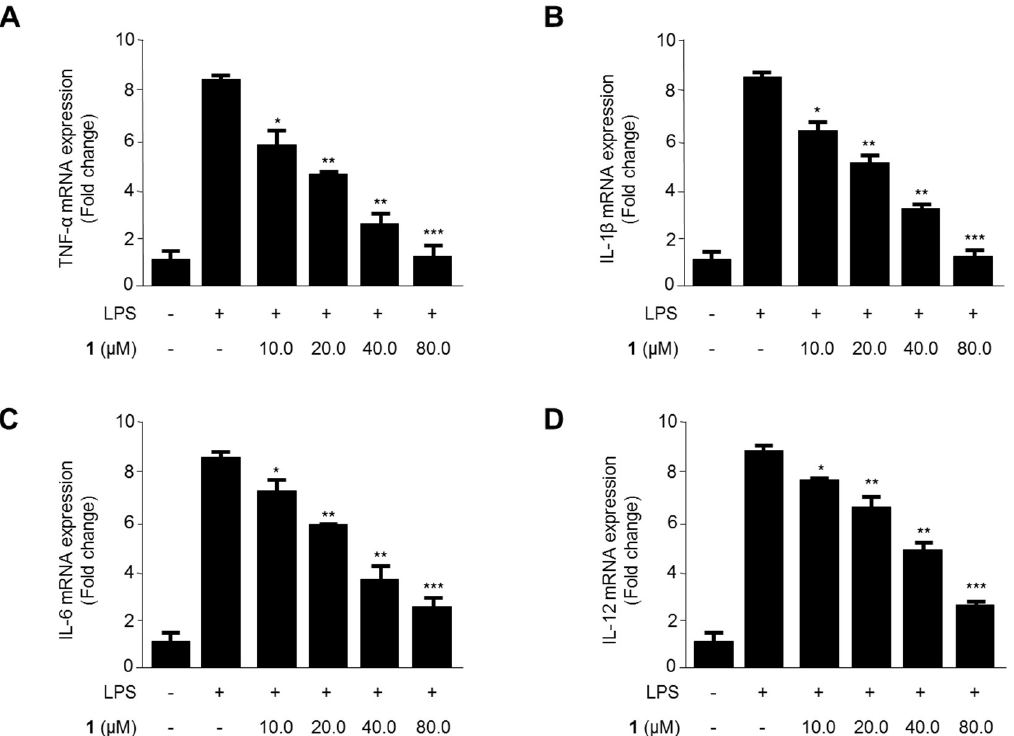
Figure 8. The effects of steppogenin ( 1 ) on the mRNA expression of TNF-α ( A ), IL-1β ( B ), IL-6 ( C ), and IL-12 ( D ) in LPS-stimulated primary rat microglial cells. ( A – D ) The cells were pretreated for 3 h with the indicated concentrations of 1 and then stimulated for 12 h with LPS (1 μg/mL). The data are presented as the mean ± SD of three experiments. * p < 0.05; ** p < 0.01; *** p < 0.001 compared with the LPS-treated group.